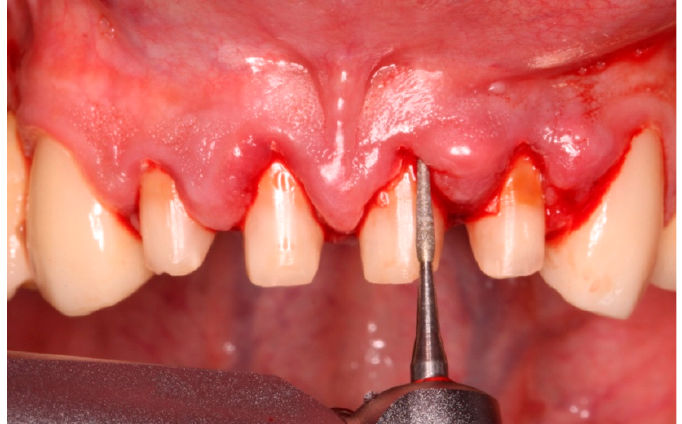
Figure 1. Intrasulcular vertical preparation with diamond burs of 100–120 µm. The cemento–enamel junction is completely removed, and bleeding can be observed.